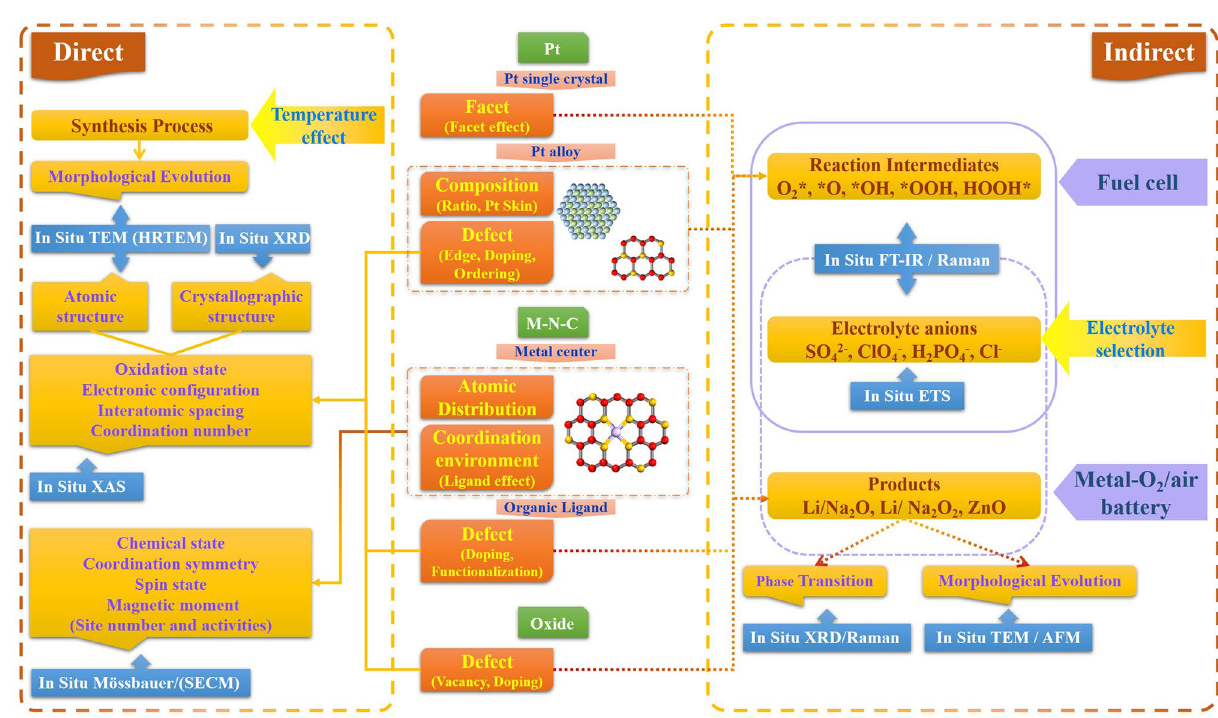
Fig. 5 Overview diagram of various direct and indirect in-situ characterization techniques for revealing structural evolution of Pt-based, M–N–C and some oxide